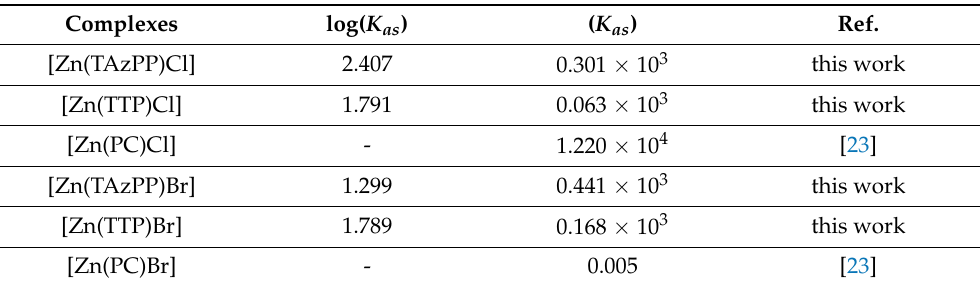
Figure 3. Evolution of the Q and Soret bands: ( a ) complex ( 4 ) as a function of the addition of the Cl − anion, ( b ) [Zn(TTP)] as a function of the addition of the Cl − anion, ( c ) complex ( 4 ) as a function of the addition of the Br − anion, and ( d ) [Zn(TTP)] as a function of the addition of the Br − anion. Table 2. Values of association constants ( K as ) and log( K as ) for our zinc(II) metalloporphyrins and other related